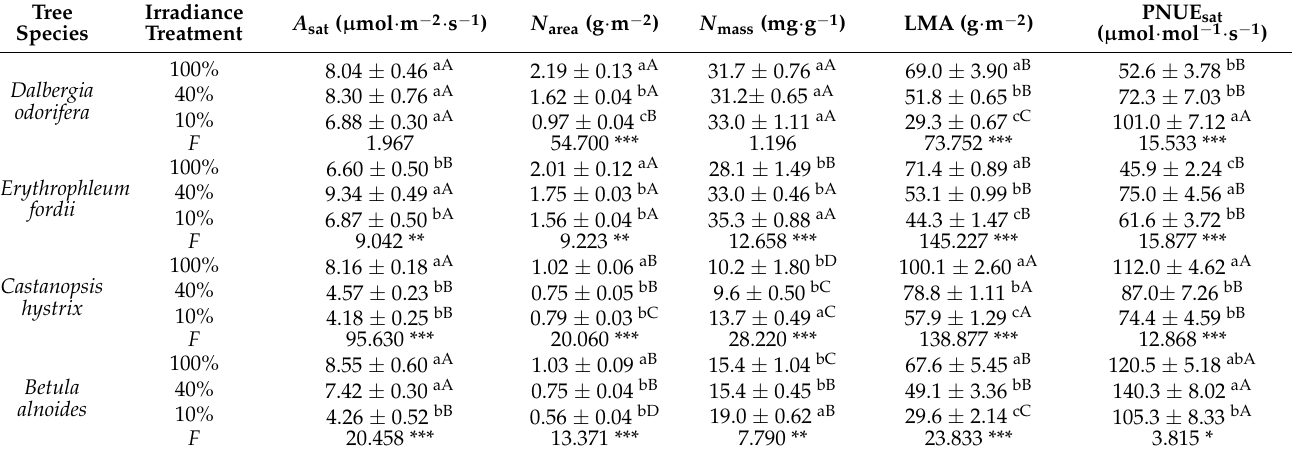
Table 1. PPFD-saturated net CO 2 assimilation rate ( A sat ); leaf mass per unit area (LMA); leaf nitrogen (N) content per unit of leaf area ( N area ); leaf N concentration ( N mass ) and PPFD-saturated photosynthetic N use efficiency (PNUE sat ) in Dalbergia odorifera , Erythrophleum fordii, Betula alnoides , and Castanopsis hystrix grown under three different irradiance treatments. Data are means of seven plants per treatment ± SE. Lower case letters indicate significant difference at 0.05 levels among the irradiance treatments, whereas capital letters indicate significant difference at 0.05 levels among species under same irradiance treatment. F -ratios with statistically significant values denoted by * p < 0.05, ** p < 0.01, *** p < 0.001 among irradiance